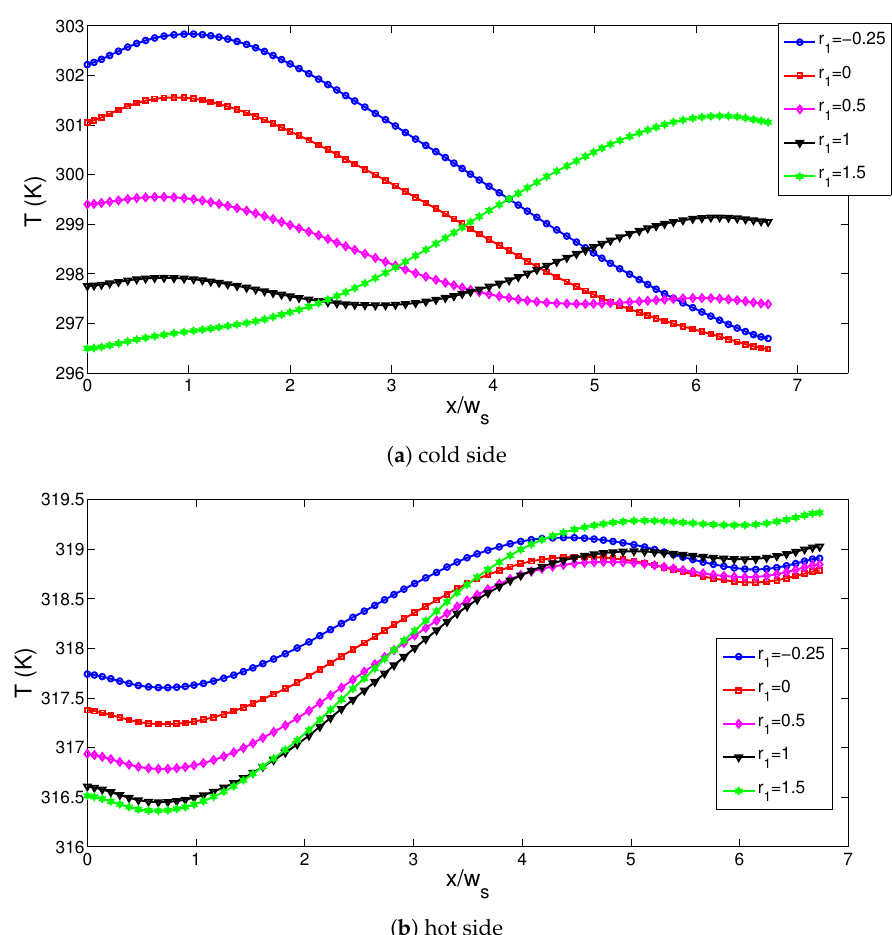
Figure 10. Impacts of jet inlet horizontal location combinations on the variation of the interface temperatures at the cold ( a ) and hot side ( b ) of the TEG module ((Re 1 , Re 2 ) = (500, 500), z h = 3w s , φ =